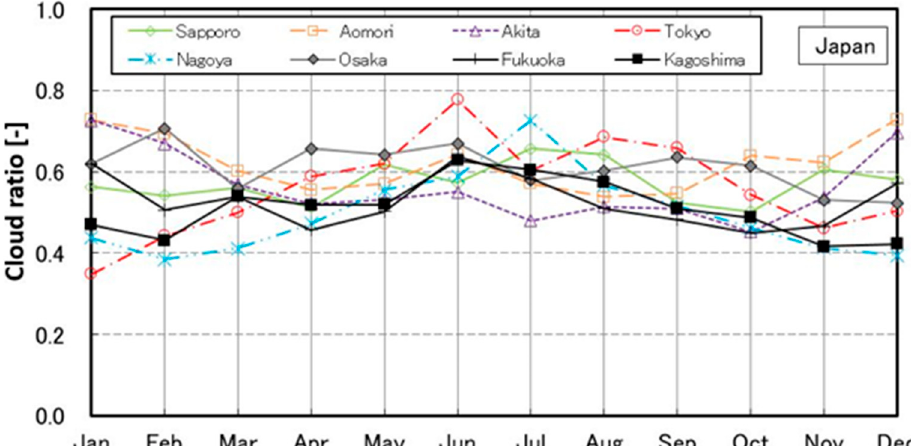
Figure 2. Comparison of monthly cloud ratios among eight main sites of Japan.